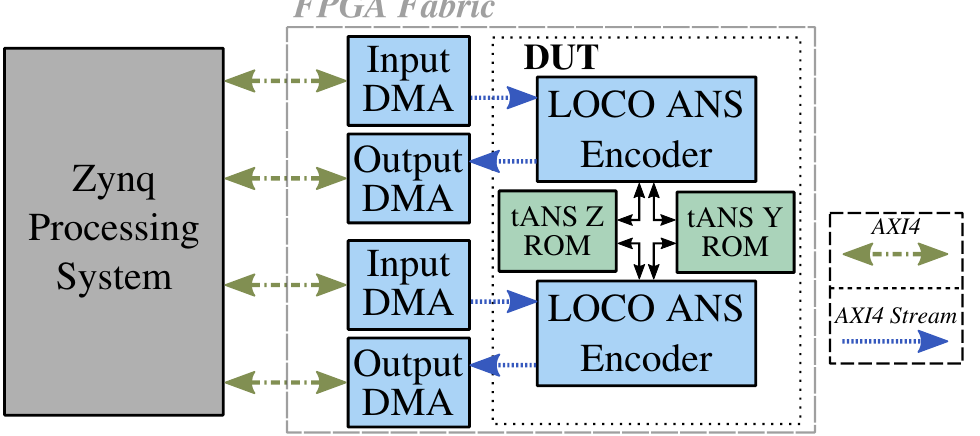
Figure 9. Block diagram of the accelerator, µ P, and interfaces. Table 1. Characteristics of target parts used in this work.